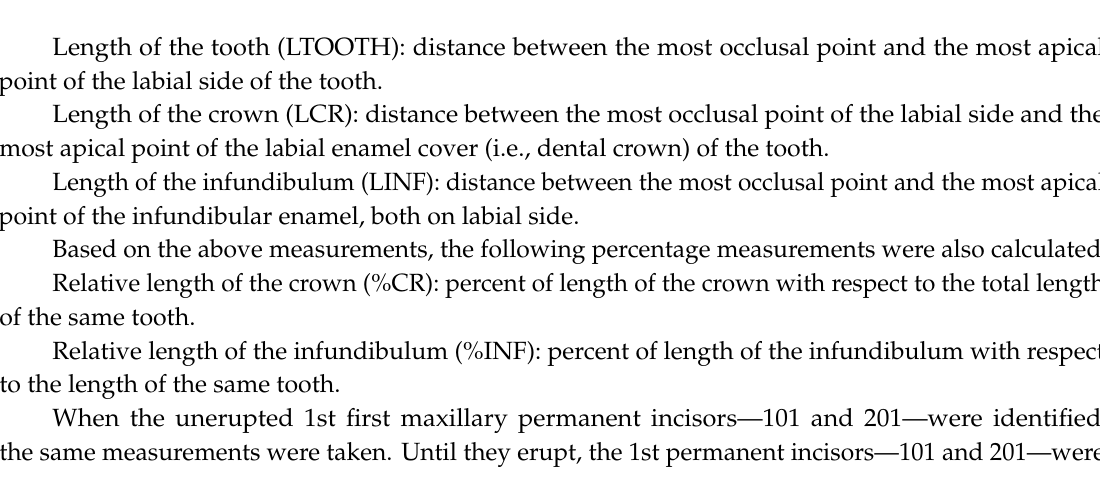
Figure 1. Sagittal computed tomography (CT) scan at midlevel of the 1st left maxillary deciduous incisor—601—of a skull of group 1d (supposedly the oldest among those with estimated age of between 12 and less than 30 months) showing the reference points for length measurements in the left maxillary 1st deciduous incisor—601— and in the unerupted 1st left permanent incisor—201. 1 and 6 , most occlusal points of the labial side of the teeth; 2 and 7 , most apical points of the labial enamel cover of the teeth; 3 , most apical point of the labial side of the 1st left maxillary deciduous incisor—60—; 4 and 6 , most occlusal points of the infundibular enamel, labial side; 5 and 8 , most apical points of the infundibular enamel, labial